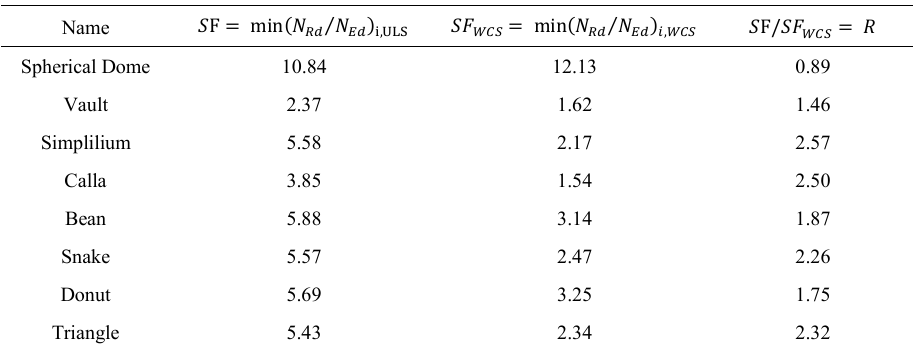
Table 4: Safety factors and redundancy rate on different models.